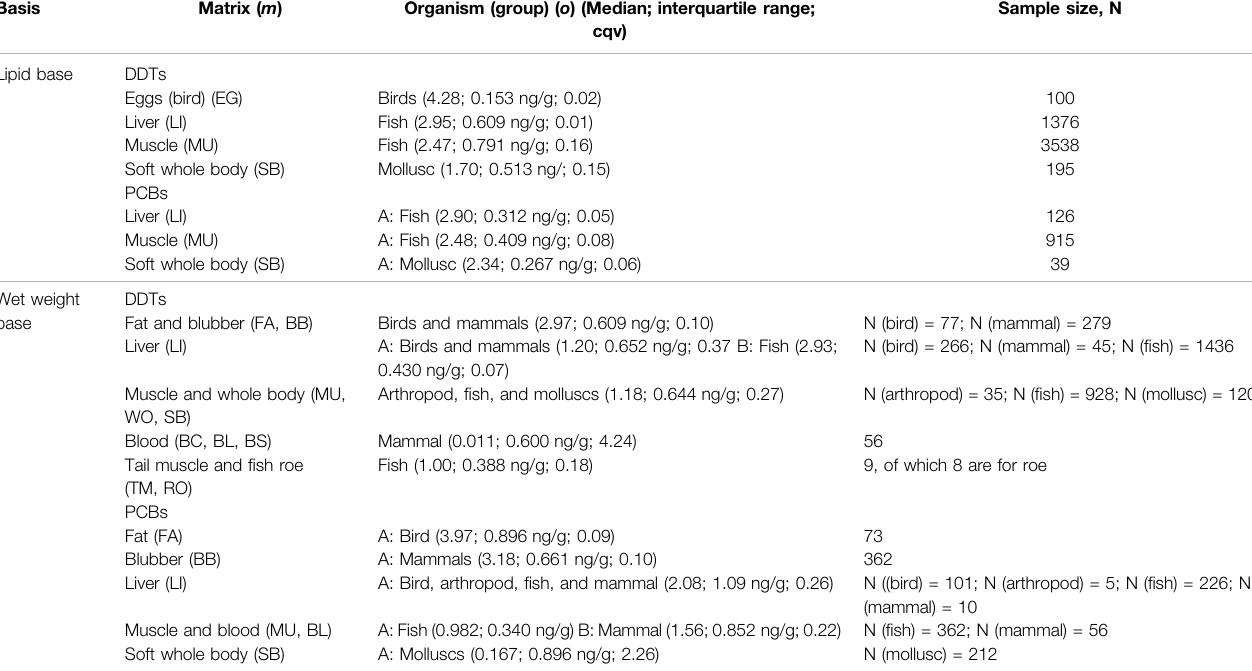
TABLE 2 | Concentration of DDTs and PCBs in marine organisms (M s,o,m,b ).